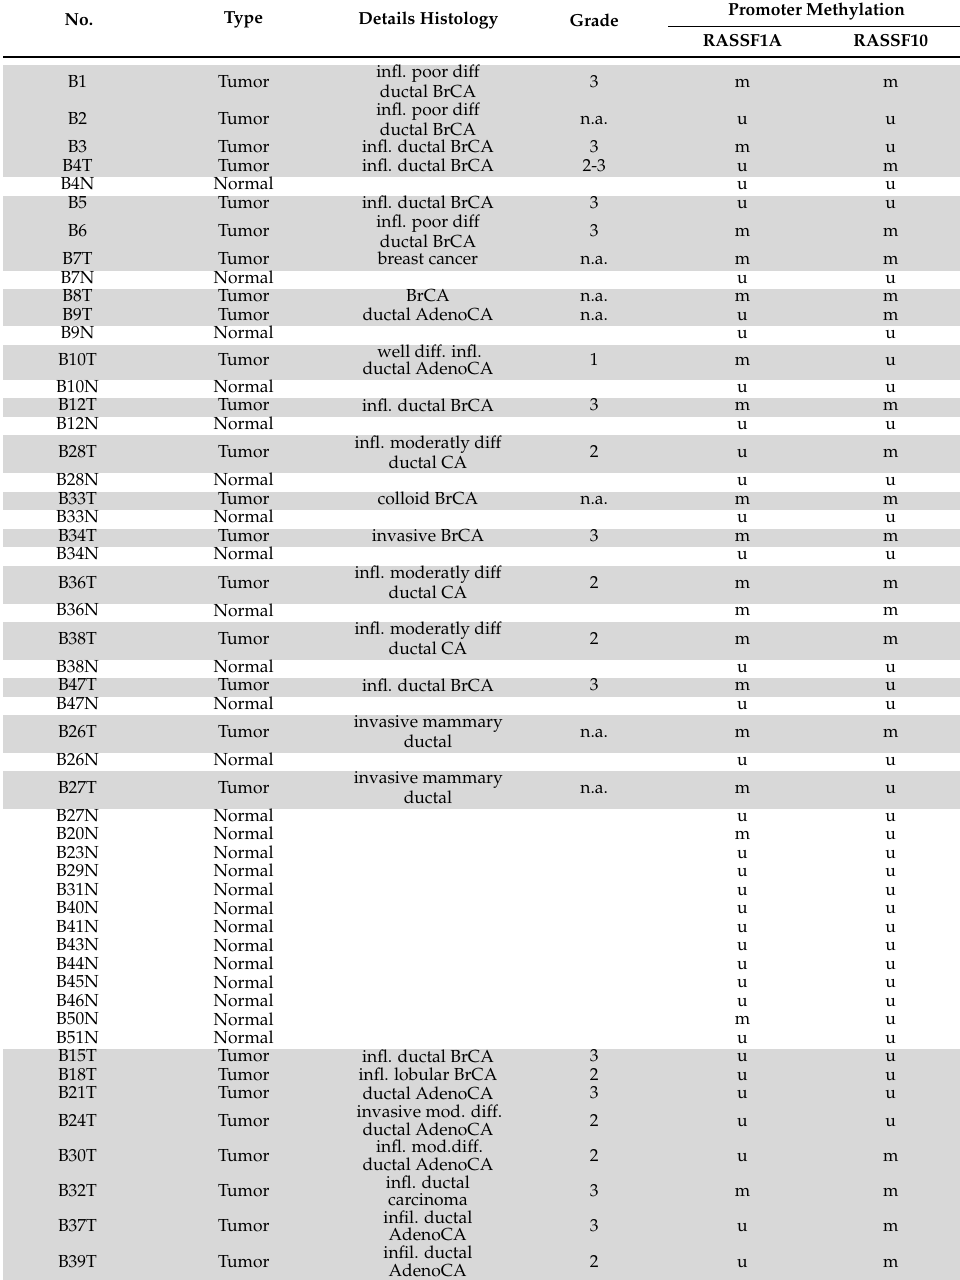
Table A1. RASSF methylation of primary breast